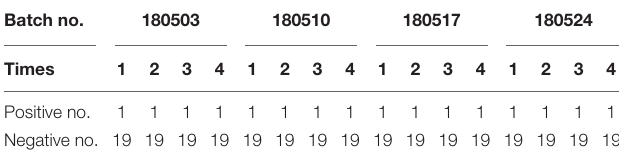
TABLE 2 | Test for reproducibility and stability of the ICS. Batch no.